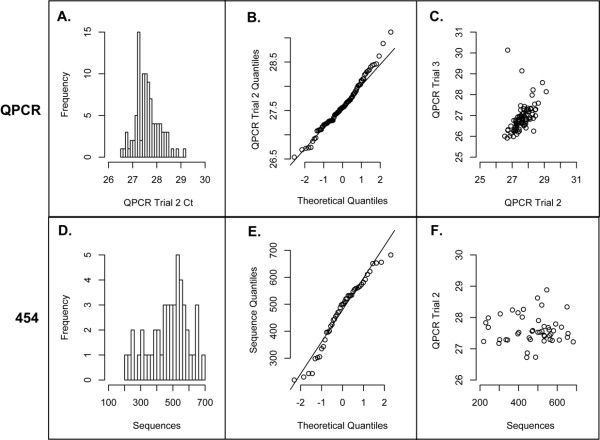
Functional assessment of barcoded primers by quantitative PCR and pyrosequencing analysis. A. Distribution of Ct scores for 96 barcoded LSU559 primers tested under identical reaction conditions. Bars represent relative frequency of occurrence of Ct scores. B. Q-Q plot of sample Ct scores versus those drawn from a theoretical normal distribution. Line denotes expected values for data obtained from a normal distribution. C. Scatterplot of Ct scores for each barcoded primer assayed in two separate PCR experiments and using different primer aliquots. The Pearson correlation coefficient of the two data sets is 0.48. B. Distribution of trimmed pyrosequencing reads for each of 47 barcoded LSU559 primers tested under indentical reaction conditions. Bars represent relative frequency of occurrence of sequence lengths (nts). E. Q-Q plot of pyrosequencing read lengths versus those drawn from a theoretical normal distribution. Line denotes expected values for data obtained from a normal distribution. F. Scatterplot of pyrosequencing read lengths vs. Ct scores for each barcoded primer assayed by pyrosequencing. The Pearson correlation coefficient of the two data sets is -0.01.